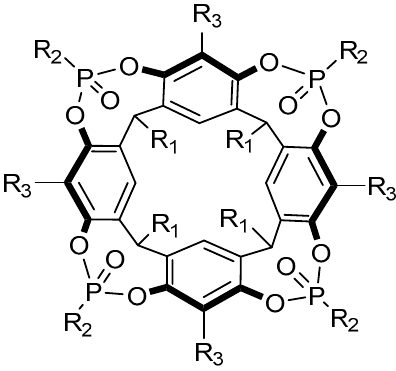
Figure 11. General structure of the Dalcanale cavitand receptors, Cav[R 1 ,R 2 ,R 3 ] [113–115].